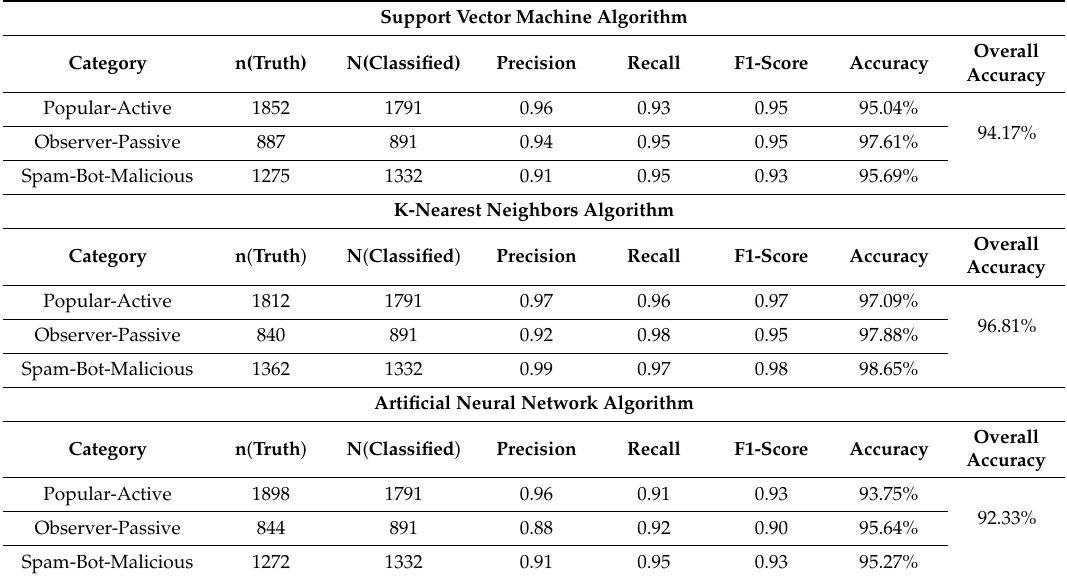
Table 6. Accuracy, precision, recall, F1-Score values for the classification